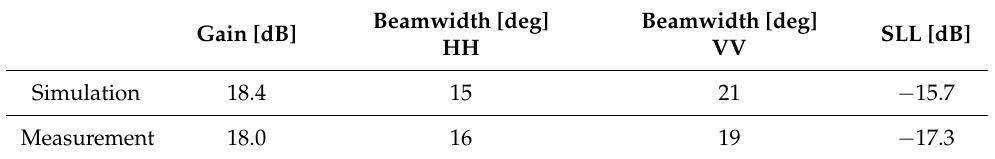
Table 3. Comparison of antenna radiation